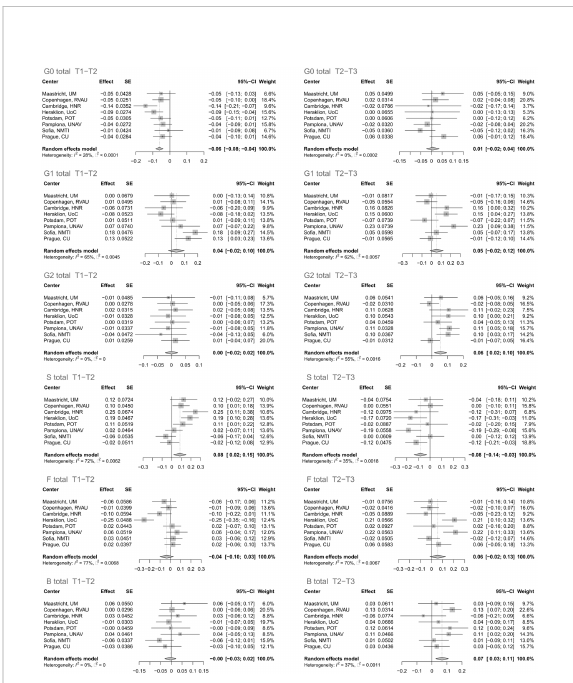
FIGURE 1 Effect of calorie loss on the immunoglobulin G (IgG) glycome in the fi rst time period (T1 – T2) and effect of different weight maintenance diets on the IgG glycome in the second time period (T2 – T3). Changes in IgG glycome composition after performing meta-analysis for all the centers are shown. SE, standard error; 95% CI, 95% con fi dence interval; T1, time point 1; T2, time point 2; T3, time point 3; G0, agalactosylated glycans; G1, monogalactosylated glycans; G2, digalactosylated glycans; S, glycans containing sialic acid; F, glycans with core fucose; B, glycans with bisecting